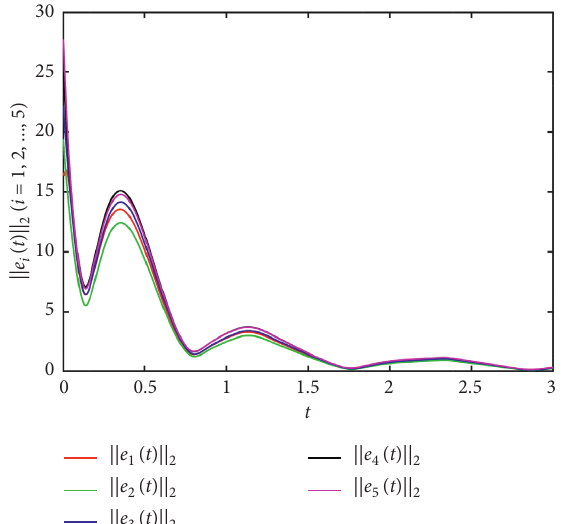
Figure 3: The changes of ‖ e